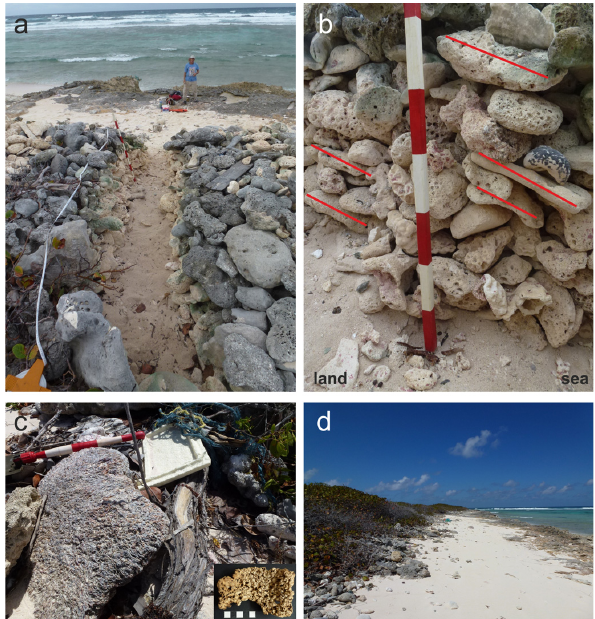
Fig. 3. Detailed views of the trench at transect II. (a) View through trench towards sea. Note the dark grey surface of weathered clasts in the upper part. (b) Details of the lower and middle part of the ridge. The ridge is resting on top of coarse grained sand, but no sand is present in between the clasts. Some flattened clasts display a landward imbrication (indicated by red lines). (c) Ropes, styrofoam and pieces of plastic trapped under a serpulite rock boulder. The inset shows a piece of cork that was trapped ca. 40cm deep in the trench. (d) Incompletely developed coral-rubble